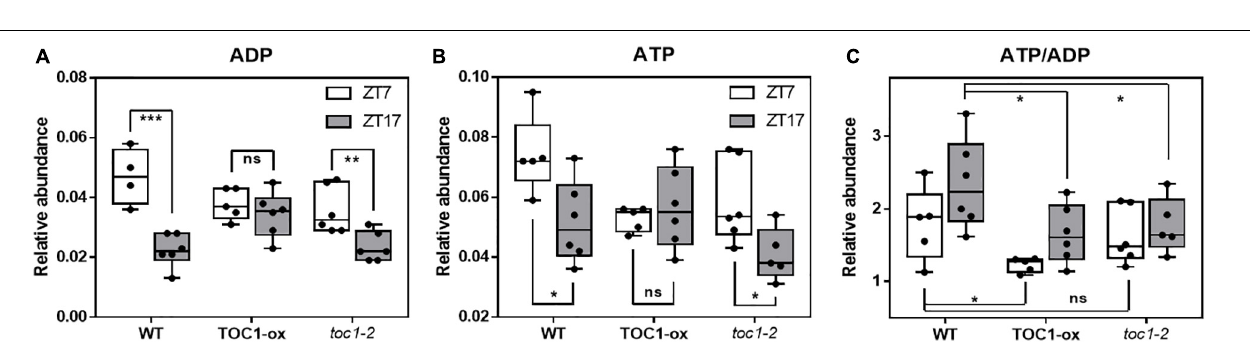
FIGURE 4 | Proper expression of TOC1 is important for the regulation of energy homeostasis. HPLC analyses of (A) ADP, (B) ATP and (C) ATP/ADP ratio in WT, TOC1-ox and toc1-2 plants that were entrained under 12 h light: 12 h dark cycles and sampled at ZT7 and ZT17. Two-tailed, T -test p -values: * p < 0.05; ** p < 0.01; *** p < 0.001. ns, not significant. Data are the result of five biological replicates, with plants grown independently at different